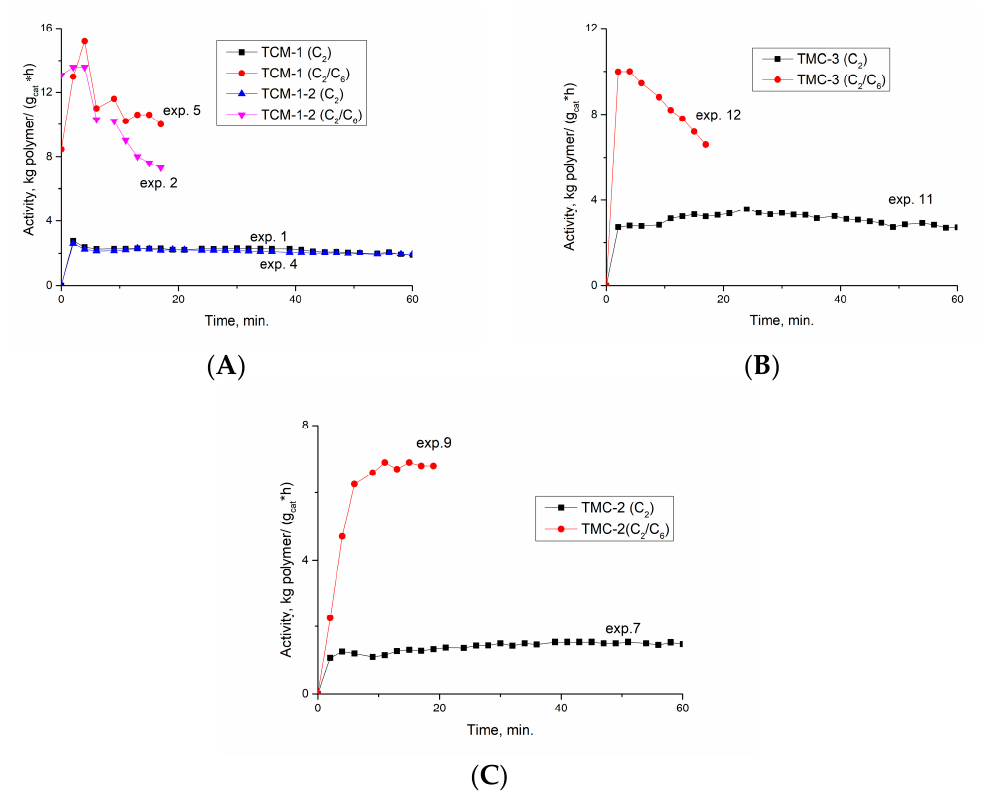
Figure 1. Kinetic curves of ethylene homopolymerization and ethylene–1-hexene copolymerization over TMC with different compositions of the active component (( A )—TMC-1 and TMC-1-2; ( B )—TMC-3; ( C )—TMC-2) (the numbering of kinetic curves corresponds to the numbering of experiments in Table 2).